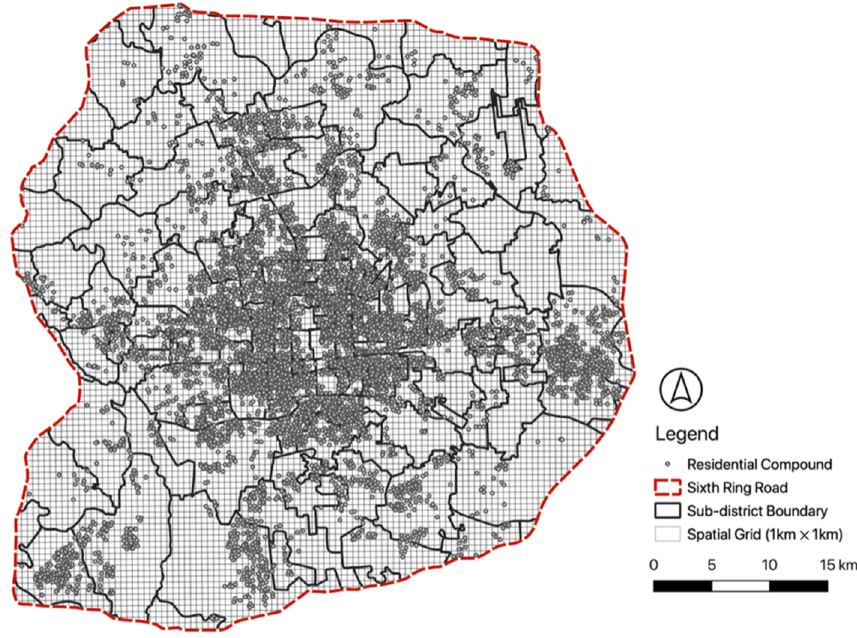
Figure 6. Real estate compounds ( n = 6678) within sixth ring road in Beijing with the spatial grid ( n = 9251) and sub-districts ( n = 167). Table 4. Results from a global regression and GWR model of real estate price.